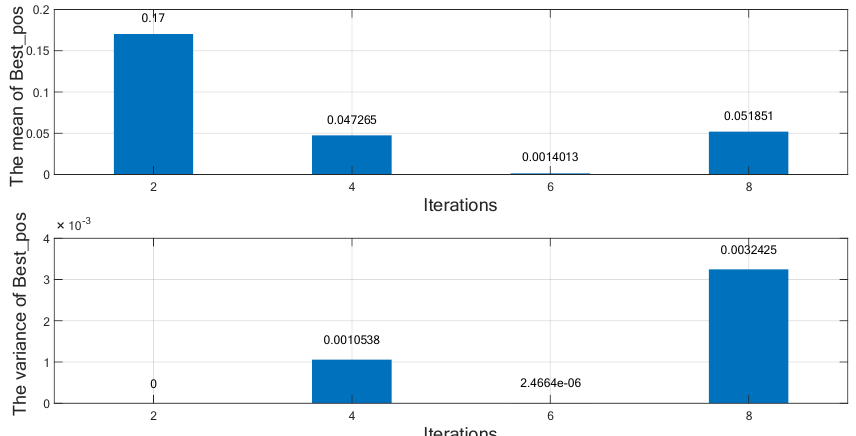
Figure 9. The value and variance of the optimal search agent for the MDE-WOA-PNN algorithm.